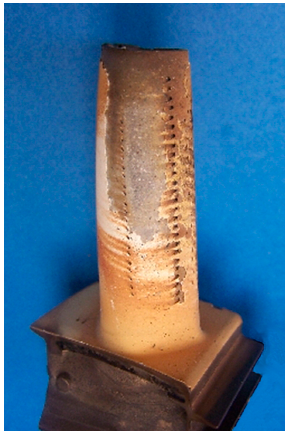
Figure 11. Image of the leading edge of an engine-run high-pressure turbine blade showing severe foreign object damage. Note the large gray region which indicates bond coat exposed by complete removal of the TBC. Reprinted with permission from [40]; Copyright 2012 Elsevier .